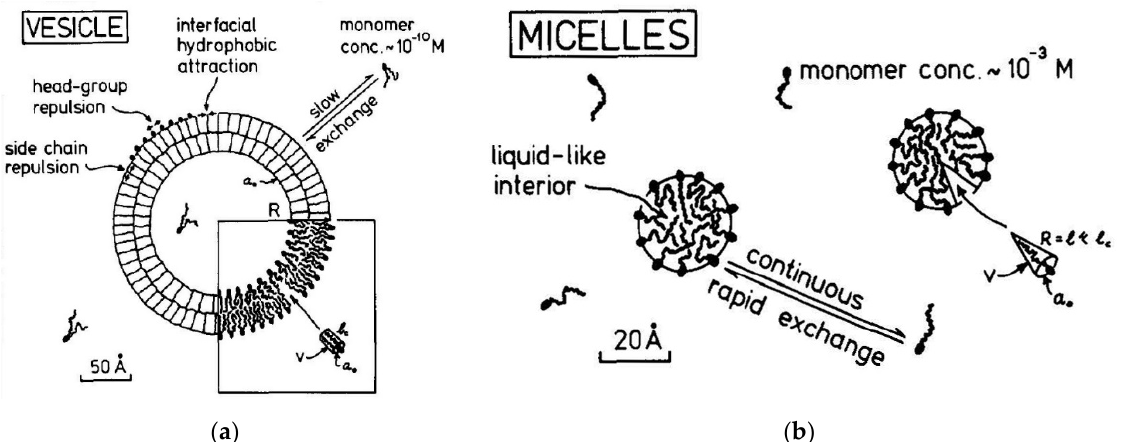
Figure 15. Schematic representation of the cross-section of ( a ) a spherical unilamellar vesicle and ( b ) spherical micelles, as published by Israelachvili et al. (1977) [125]. The drawing illustrates (i) the packing of the amphiphiles as geometric objects (see Equation (1) in Section 2.3), (ii) the interactions at the interface of the aggregates, and (iii) the exchange of the amphiphiles between the aggregated state and the molecularly dissolved state. Typical values for the concentration of non-associated amphiphiles (“monomers”) are indicated; see also the text. Reproduced with permission from [125], Elsevier,